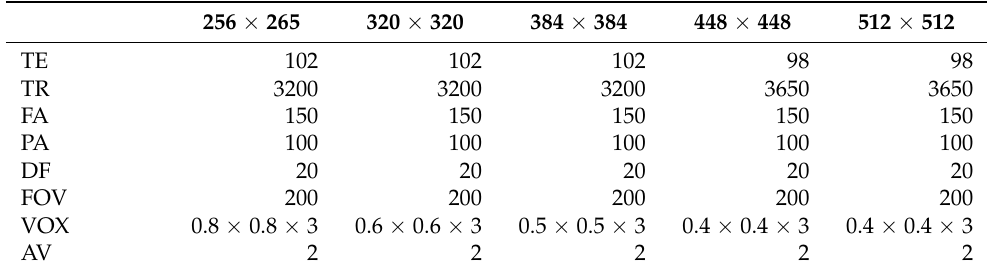
Table 1. Scanning parameters according to different matrix size. TE—time echo, TR—repetition time, FA—flip angle, PA—phase oversampling, DF—distance factor, FOV—field of view, VOX—voxel size, AV—averages.